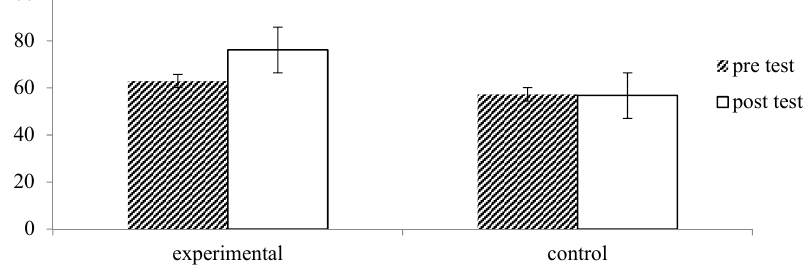
Figure 8. Effect of forest therapy on health-related quality of life, measured by EQ-VAS, with scores ranging from 0 = worst imaginable health state to 100 = best imaginable health state.